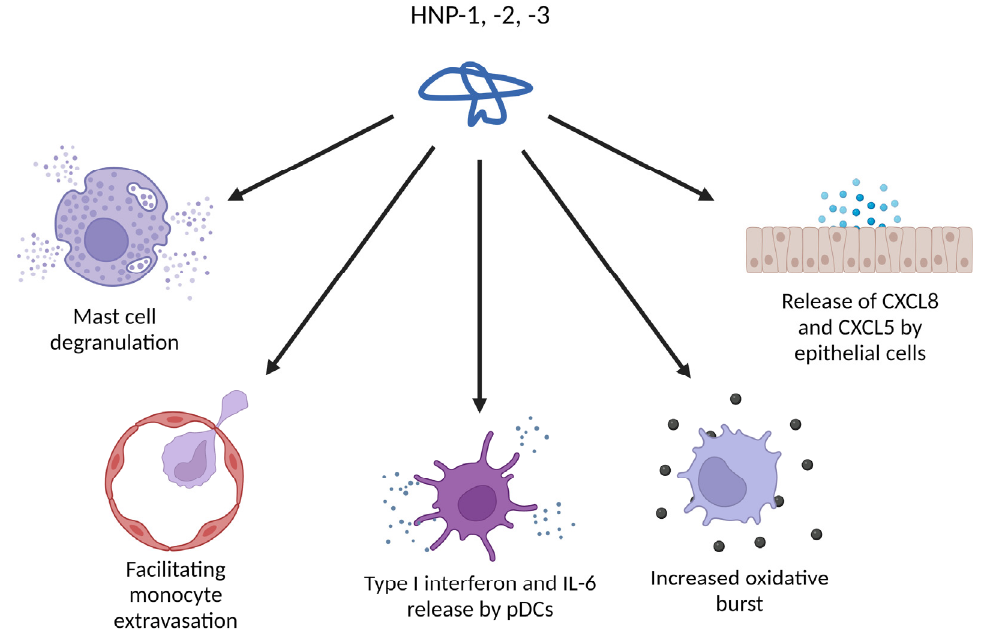
Figure 4. Immune-related activities of HNPs that can be relevant in the tumor microenvironment. Created with BioRender.com.